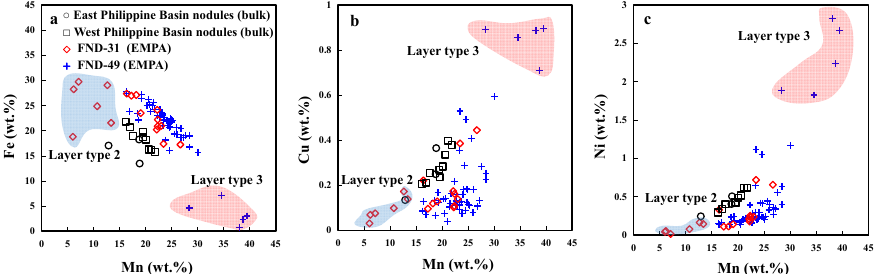
Figure 4. ( a – c ): Relationships of Mn with Fe, Ni, and Cu in the nodules.